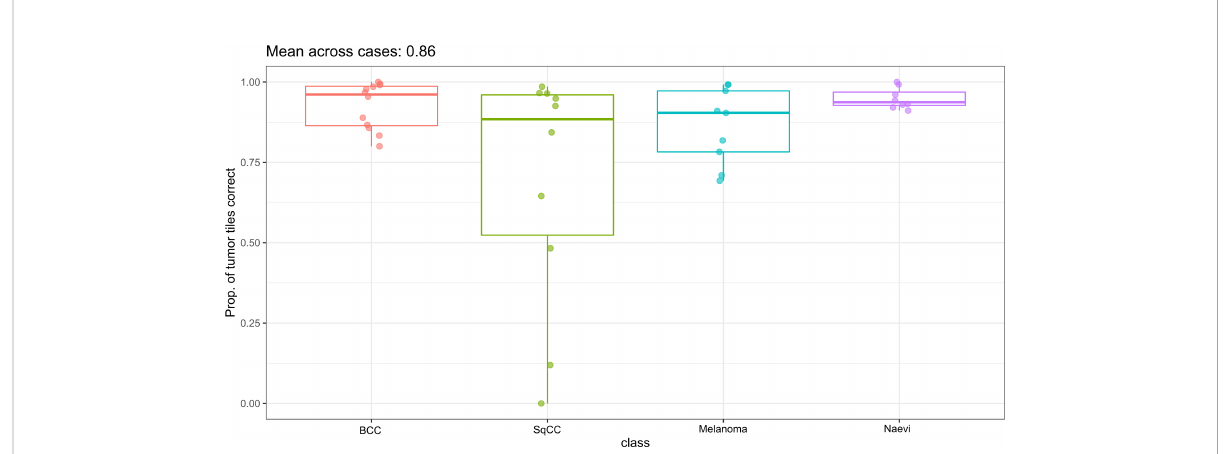
FIGURE 4 Proportion of tumor image tiles that was correctly classi fi ed on patient level in the validation set. Most tumors were correctly classi fi ed on patient level. Two patients with squamous cell carcinomas were misclassi fi ed. BCC, basal cell carcinoma; SqCC, squamous cell carcinoma.